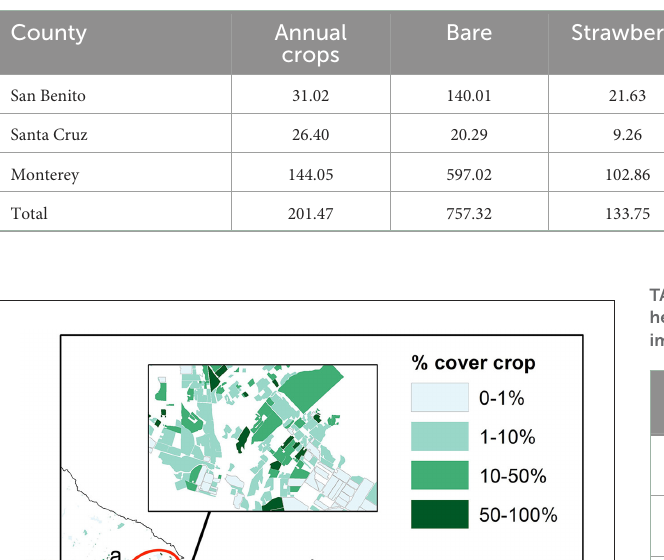
TABLE 2 Land use cover (in km 2 ) in each county from the cover crop classifier.